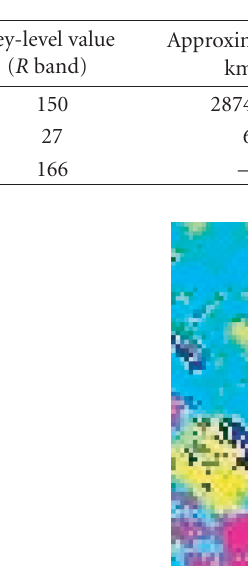
Table 4.2. Feature descriptors from Figure 4.4. Location is in pixel coordinates.